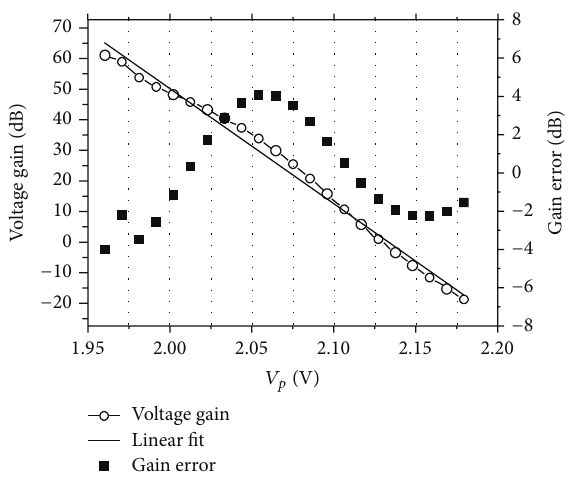
Figure 13: Noise figure at maximum gain.